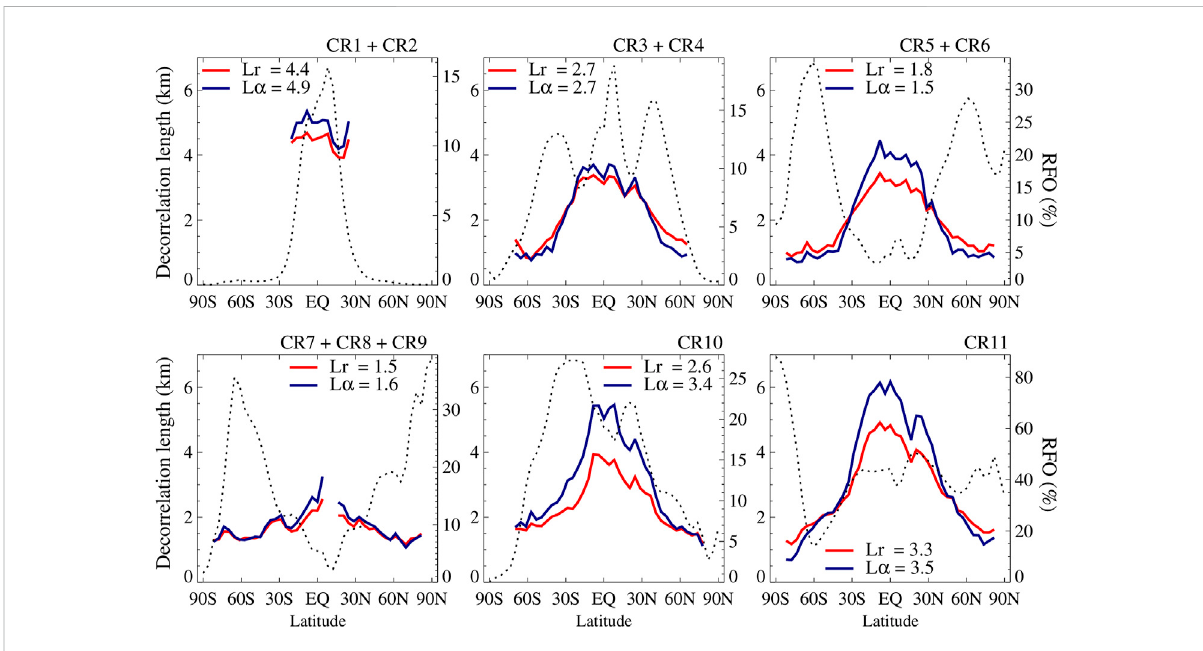
FIGURE 8 Annuallyaveragedzonalcurvesof L α and L ρ forgroupsofcloudregimes(CRs)fromtheO22 fi lledCODdataset;globalaveragevaluesareshown in each panel. These results are obtained by identifying the coincident Aqua-MODIS CR for each of our scenes and then deriving decorrelation lengths from zonal values of α and ρ for each CR group. The dotted curve indicates the zonal Relative Frequency of Occcurrence (RFO, in %, right ordinate) of the CR